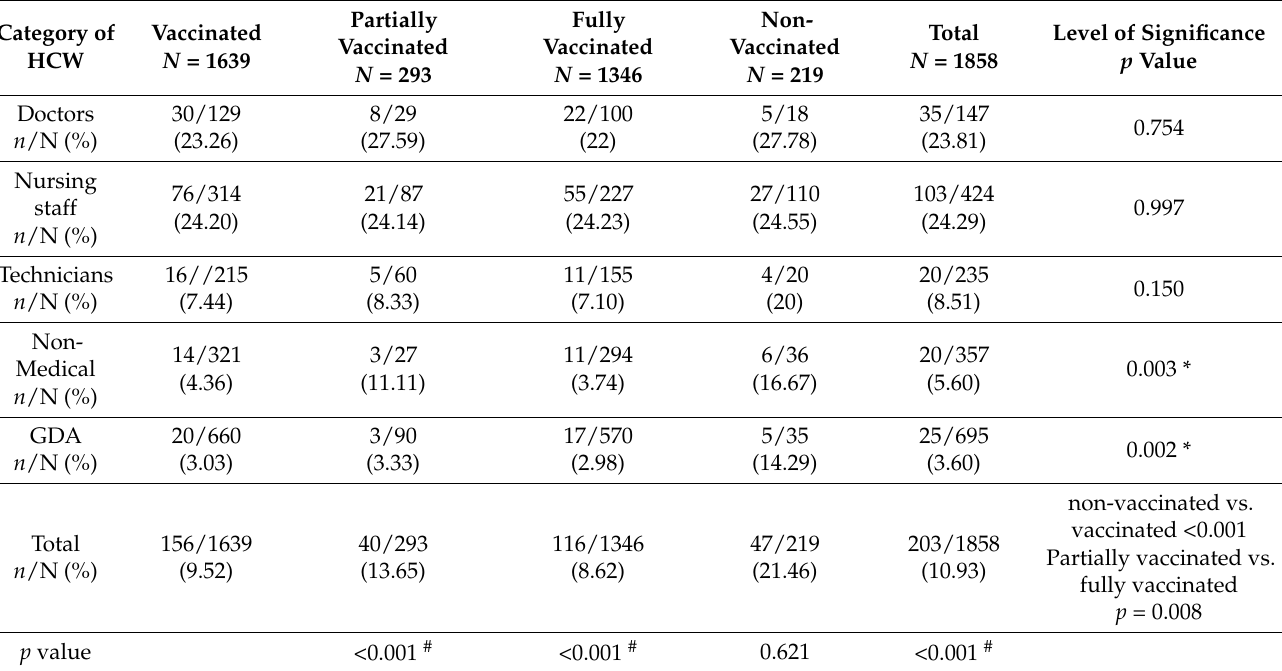
Table 1. Distribution of VBT infections as per work profile of